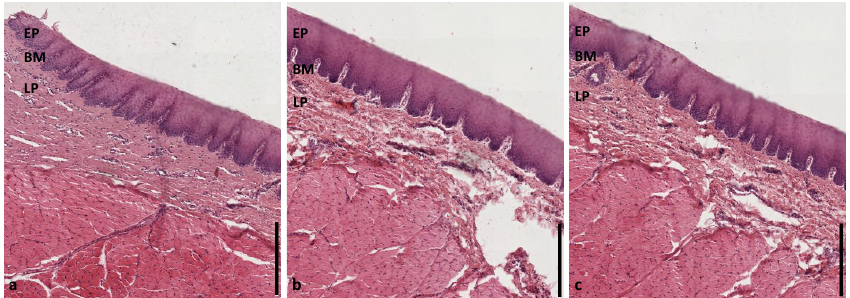
Figure A7. Supplementary HE stained histological cross sections of the human sublingual mucosa [44]. EP: epithelium, BM: basement membrane, LP: lamina propria, Scale bar: 200 µ